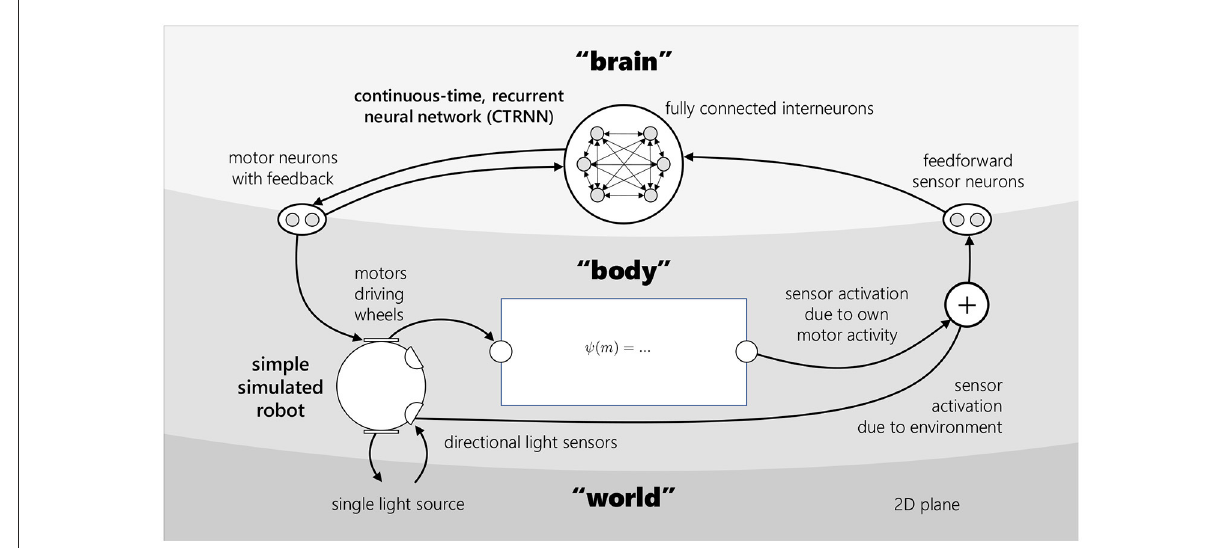
FIGURE1 An embodied model with motor-driven sensory interference. This model is used throughout the paper. It consists of three parts—the “brain,” the “body” and the “world.” The brain is a continuous-time, recurrent neural network (CTRNN), with 6 fully connected interneurons, 2 sensor neurons which project to all interneurons, and 2 motor neurons which project to and receive projections from all interneurons. The motor neurons determine the activation of the body’s 2 motors. The body’s position and orientation relative to the single light source in the environment determine the activation of its 2 light sensors. The value received at a given point in time by the right sensor neuron is a linear combination of the right light sensor activation, and a function ψ of the right motor’s activation, representing self-caused sensory stimulation—and likewise for the left sensor, sensor neuron, and